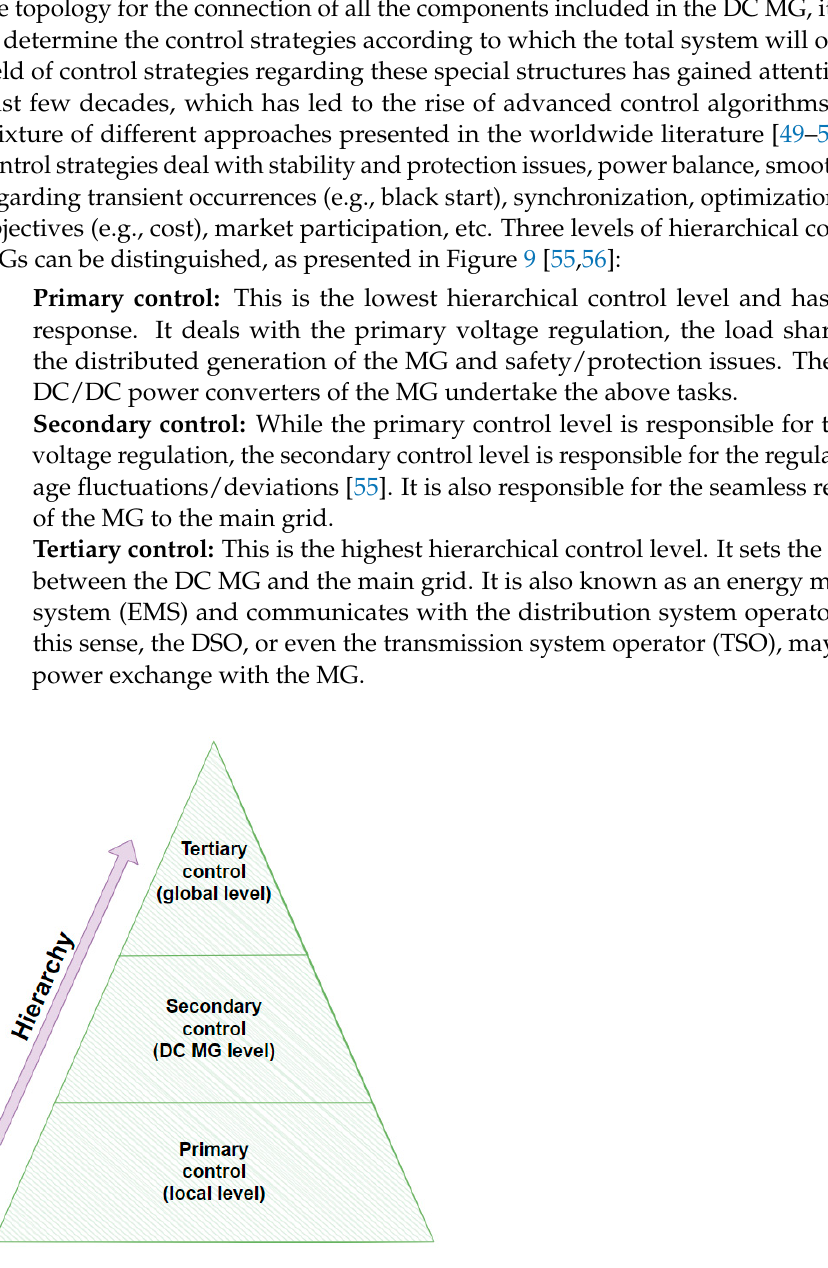
Figure 9. Hierarchical